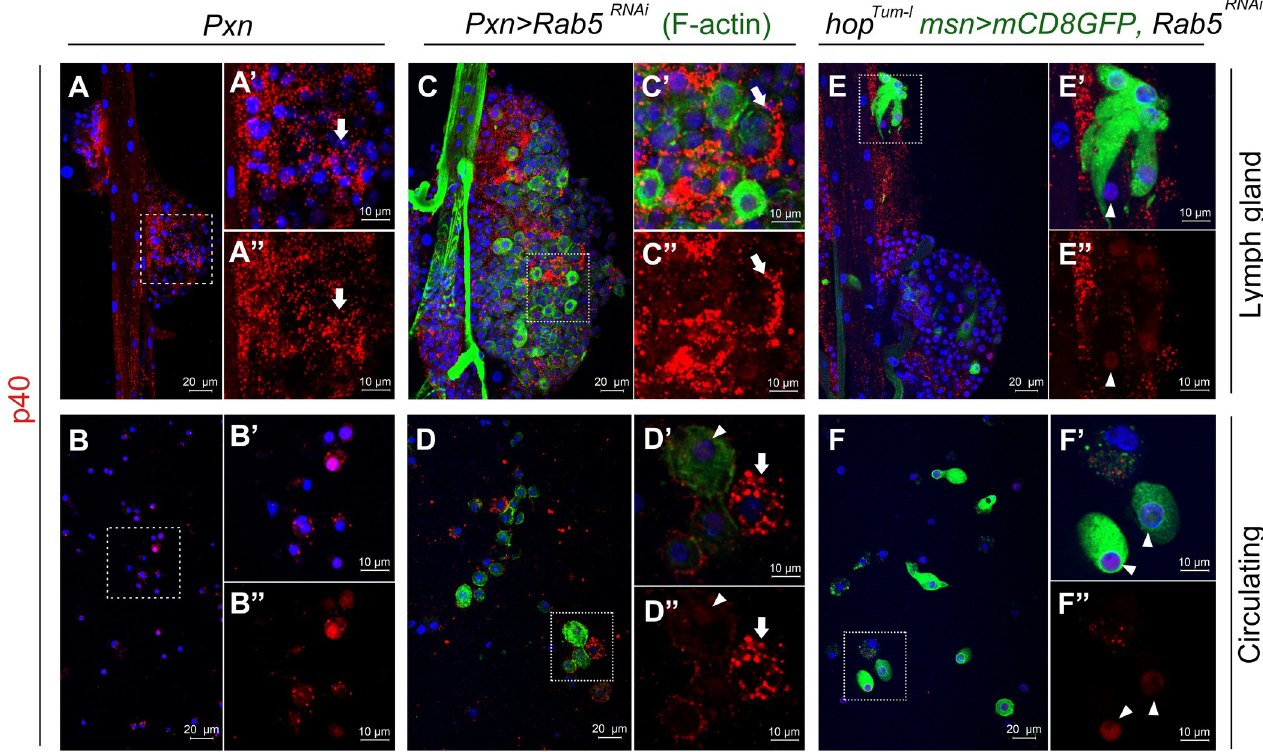
Fig 4. Intracellular Lh EV localization. ( A, B ) Anterior lobes ( A-A”) and circulating hemocytes ( B-B”) from Lh -infected Pxn > GFP animals showing EV uptake. Magnifications of areas in ( A ) and ( B ) are shown in panels A ’, A ” and B’ , B” , respectively. Arrow points to internalized vesicles. ( C, D ) An anterior lobe ( C-C ”) and circulating hemocytes ( D-D” ) from Lh -infected Pxn > GFP Rab5 RNAi animals showing peripheral localization of EVs (arrow). As in Fig 1, Pxn > GFP expression is reduced after wasp attack. Samples were counterstained with FITC-Phalloidin to visualize cell morphology. A larger Phalloidin-positive lamellocyte (arrowhead) remains EV negative, while smaller macrophages endocytose EVs. The EV signal is peripheral in some, but not all macrophages ( C, D ). ( E, F ) Anterior l Lobes ( E-E” ) and circulating hemocytes ( F-F” ) from Lh -infected GFP-positive lamellocytes of hop Tum-l msn > mCD8GFP , Rab5 RNAi animals. Lamellocytes show a diffuse nuclear SSp40 signal